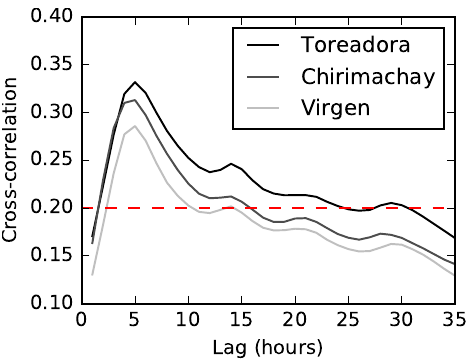
Figure 5. Pearson cross-correlation comparison between the Toreadora (3955 m.a.s.l.), Virgen (3626 m.a.s.l.) and Chirimachay (3298 m.a.s.l.) precipitation stations and the Matadero-Sayausí (2693 m.a.s.l.) discharge station. Note the horizontal line at a cross-correlation of